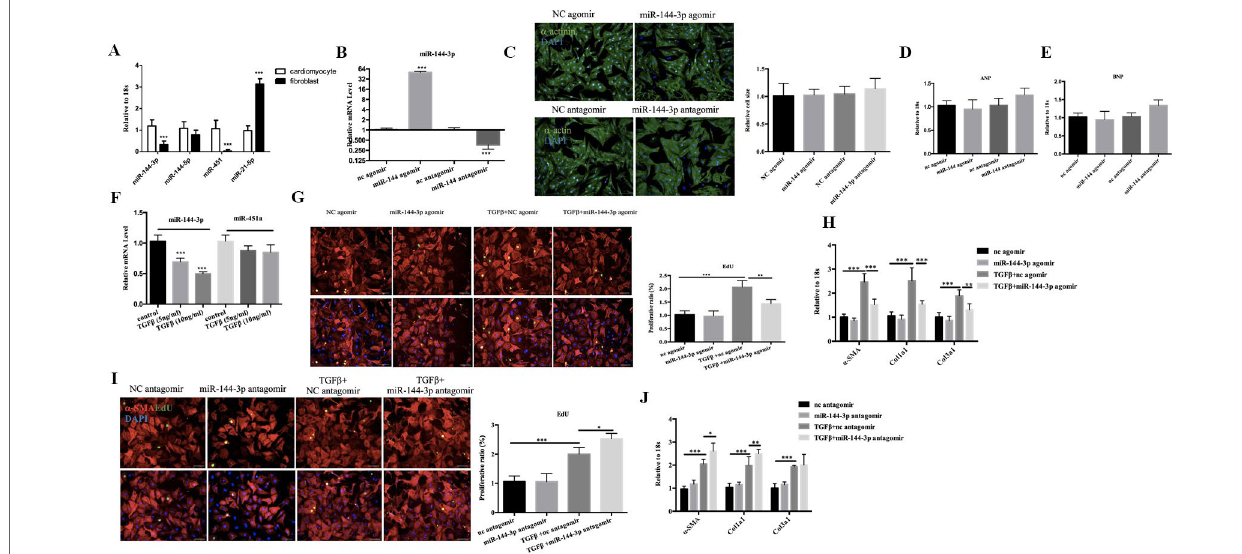
FIgURE 6 | Functional study of miR-144-3p in vitro . (A) . qRT-PCR analysis of miRNA between cardiomyocytes and fibroblasts (n = 6). (B, C) . qRT-PCR analysis of the transfection efficacy of miR-144-3p with agomir/antagomir compared to controls (n = 6). (C–E) . Overexpression or downregulation of miR-144-3p did not perform effects on cardiomyocyte cell size and pathological hypertrophic markers (ANP and BNP), as evidence by α-actin/DAPI staining (n = 4) and qRT-PCR analysis (n = 6). (F) . Decreased expression of miR-144-3p in cardiac fibrosis model induced by TGFβ (n = 6). (g, h) . Forced expression of miR-144-3p attenuated TGFβ-induced cardiac fibroblast proliferation and trans-differentiation, as evidenced by EdU/α-SMA staining (n = 4) and qRT-PCR analysis of α-SMA, Col1a1 and Col3a1 (n = 6) (I, J) . inhibition of miR-144-3p deteriorated TGFb-induced cardiac fibroblasts proliferation and trans-differentiation as evidenced by EdU/α-SMA staining (n = 4) and qRT-PCR analysis (n = 6). Scale bar: 50um. *, p < 0.05; **, p < 0.01; ***, p <